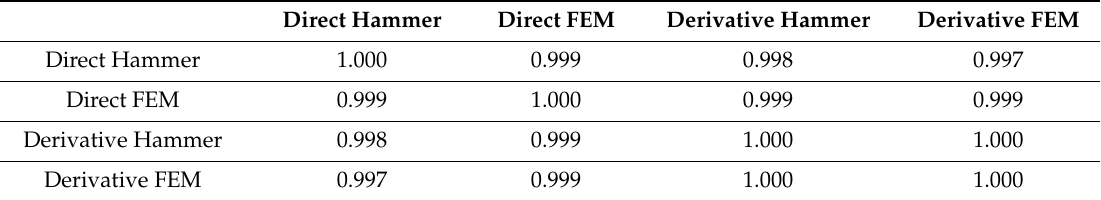
Table 5. MAC values for the first rotational mode for the UHPC1_L beam. Intact state. Direct Hammer